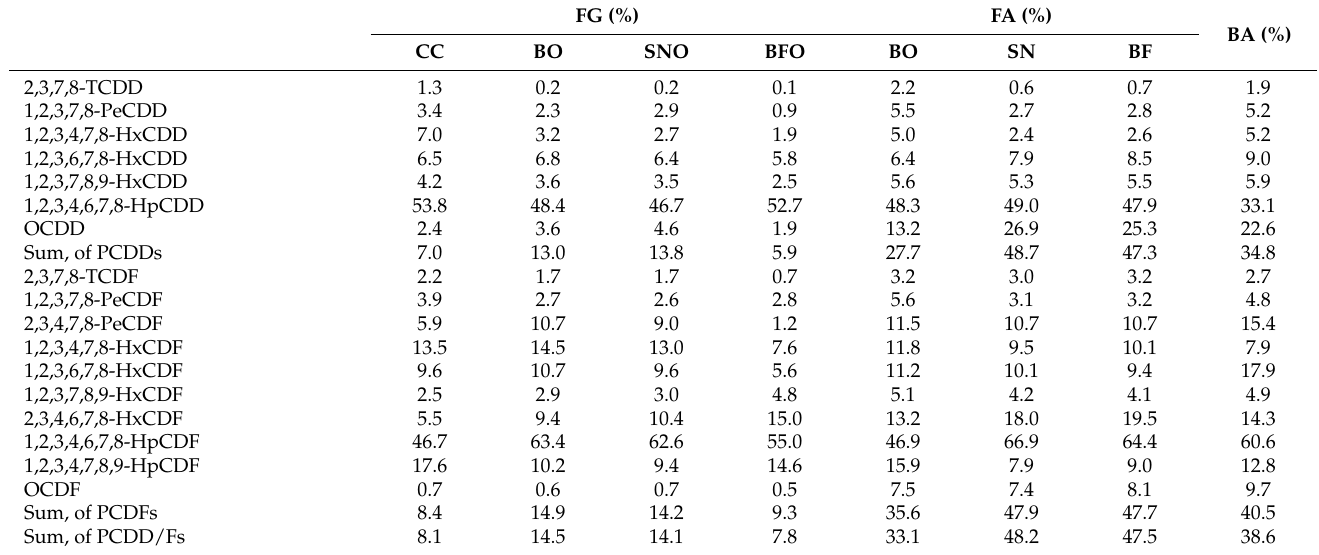
Table 4. Hagenmaier profiles of 2,3,7,8-PCDD/F isomers (%) for leather waste